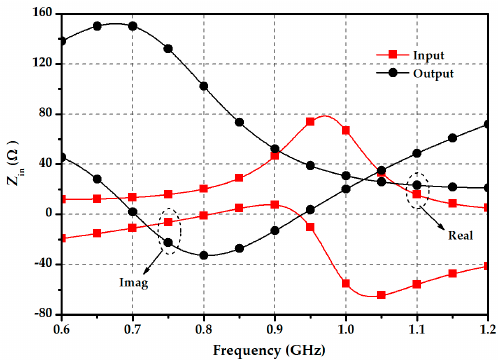
Figure 1. Impedance curves of the amplifier matched with the traditional method.